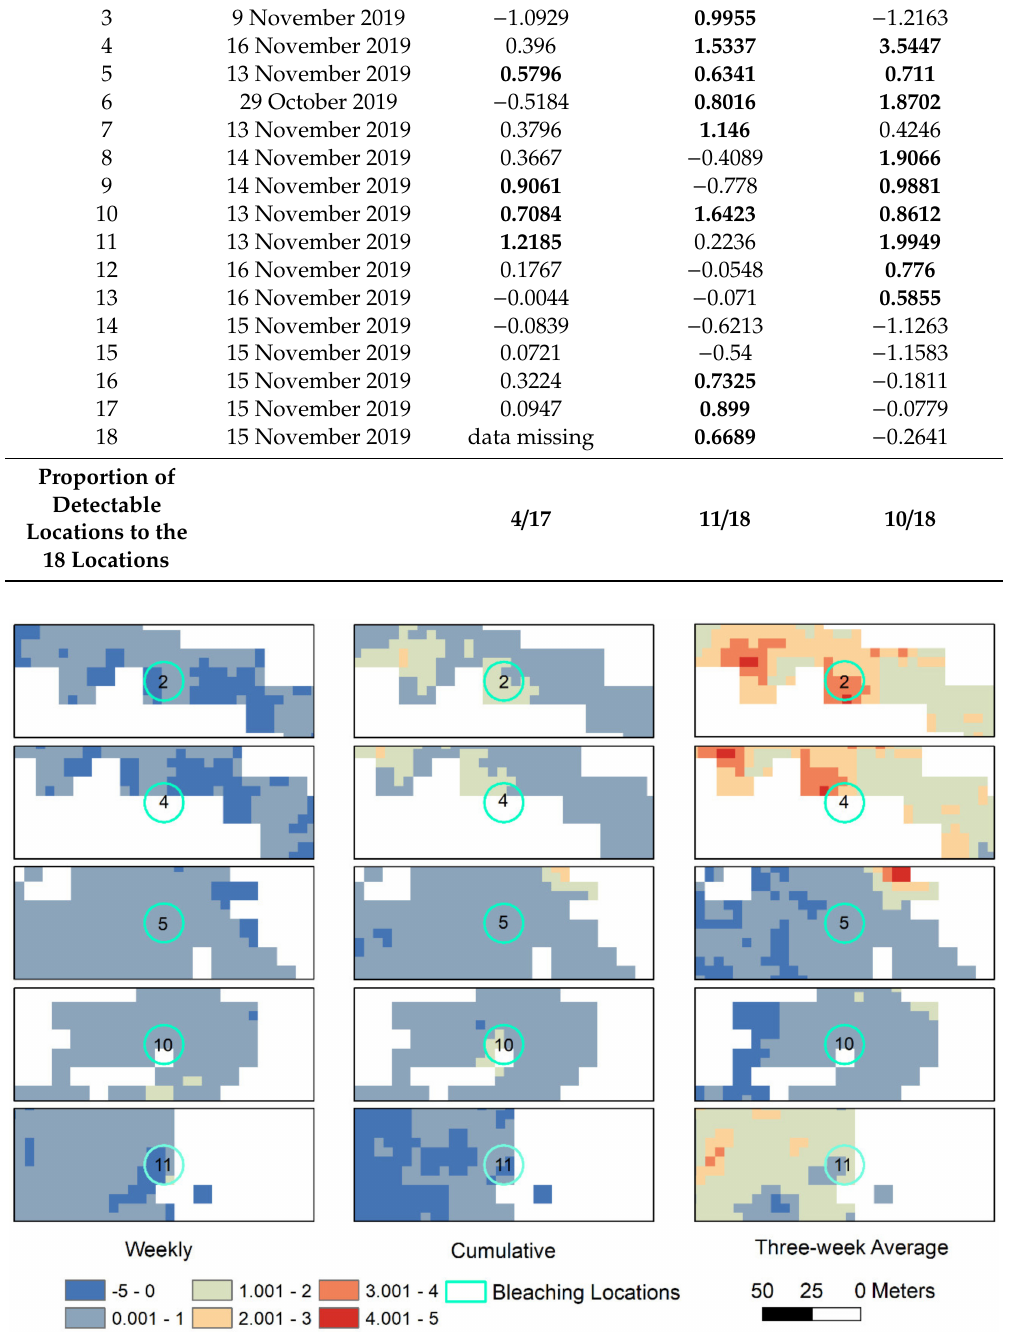
Figure6. Selectedbleachinglocationsforcomparisonsamongweekly,cumulativeaverage,andthree-week average Standardized Bottom Reflectance (Location 2 and 4, Molokai; Location 5, 10, 11,